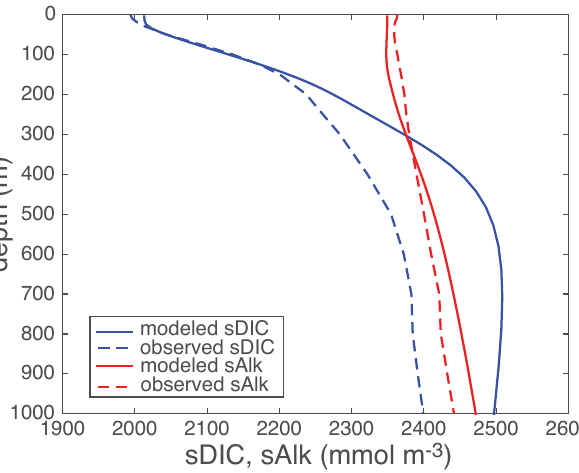
Figure 2. The vertical distribution of pre-industrial sDIC and sAlk in the eastern equatorial Pacific as estimated by the model and re- constructed from